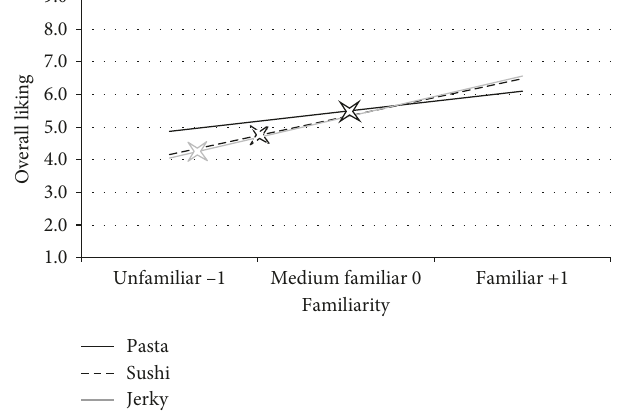
Figure 4: Overall liking of spirulina as a function of familiarity with product category (stars mark the average familiarity of each product category).